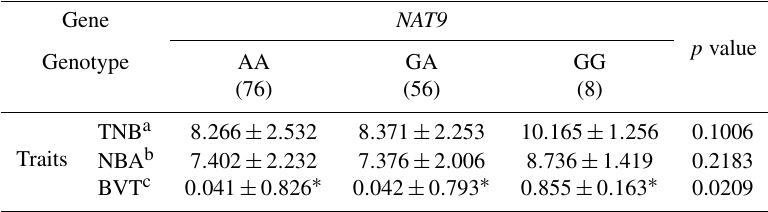
Table 3. Association of litter size traits with NAT9 genotypes in the primary experiment.